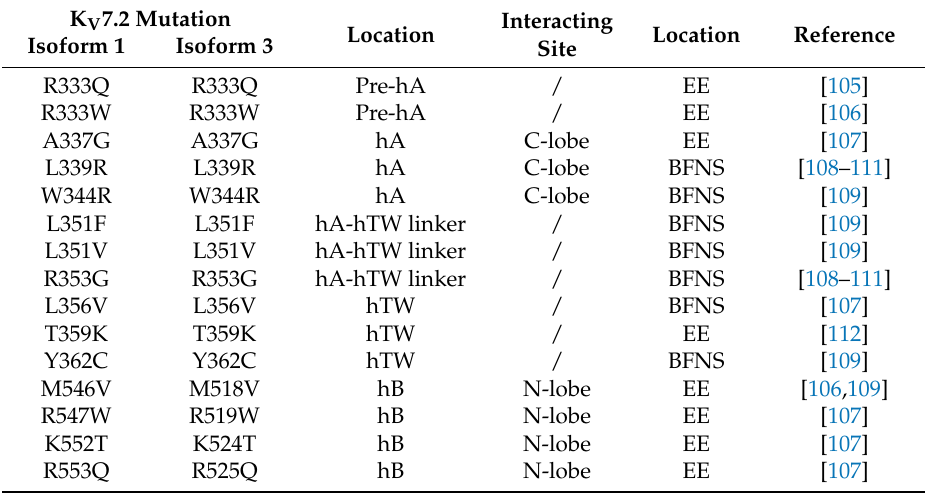
Table 4. Mutations in K V 7.2 channels influencing CaM binding. EE: epileptic encephalopathy; BFNS: benign familial neonatal seizures; hA: helix A; hTW: TW helix; hB: helix B; hD: helix